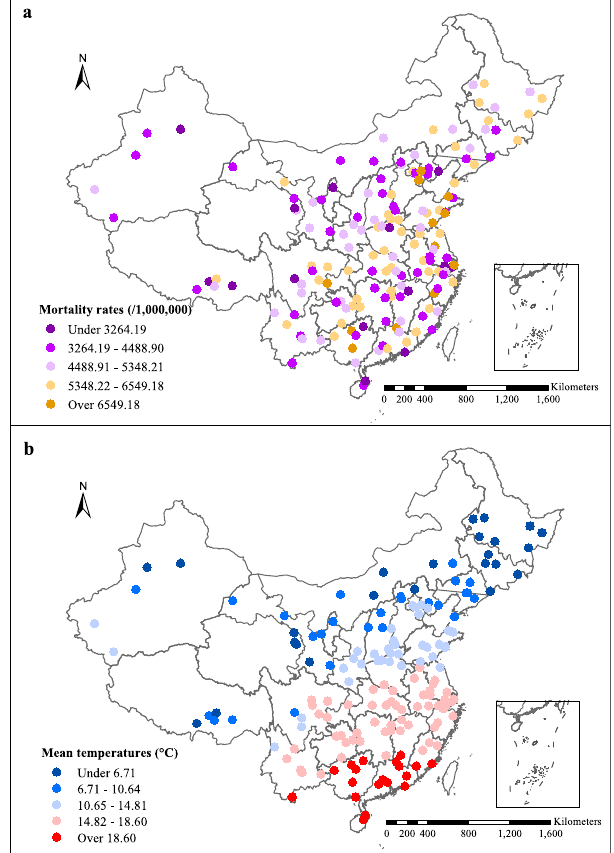
Fig. 1 The annual mortality rate (per million populations) and annual mean temperature (°C) in 161 Chinese disease surveillance points. The colors represent different ranges of a annual mortality rates and b average daily mean temperatures during 2007 – 2013. Source data are provided as Supplementary Data